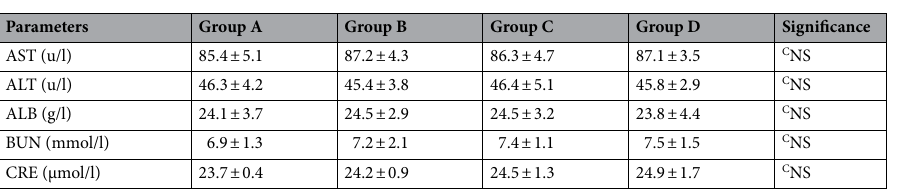
Table 1. Biochemical analysis at the end of rafoxanide treatment. Group A: No treatment. Group B: Treated with 10 mg/kg rafoxanide. Group C: Treated with 20 mg/kg rafoxanide. Group D: Treated with 30 mg/kg rafoxanide. Each value was expressed as mean ± SD ( n = 6). C NS statistically no significant difference at P < 0.05 by ANOVA-test. Statistically different from